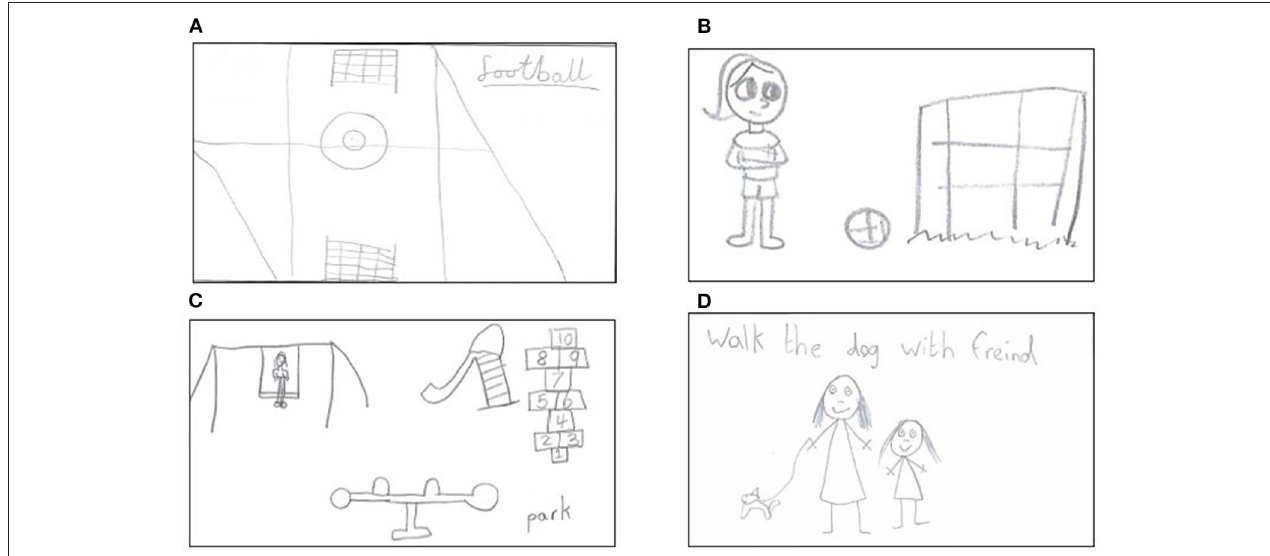
FIGURE 1 | (A) Drawing from a boy (ID9) illustrating the football pitch as where he is most likely to engage in physical activity. (B) Drawing from a girl (ID34) illustrating what she dislikes about physical activity. (C) Drawing from a boy (ID2) illustrating the places where he habitually engages in physical activity. (D) Drawing from a girl (ID17) illustrating a walk with her dog and friend.